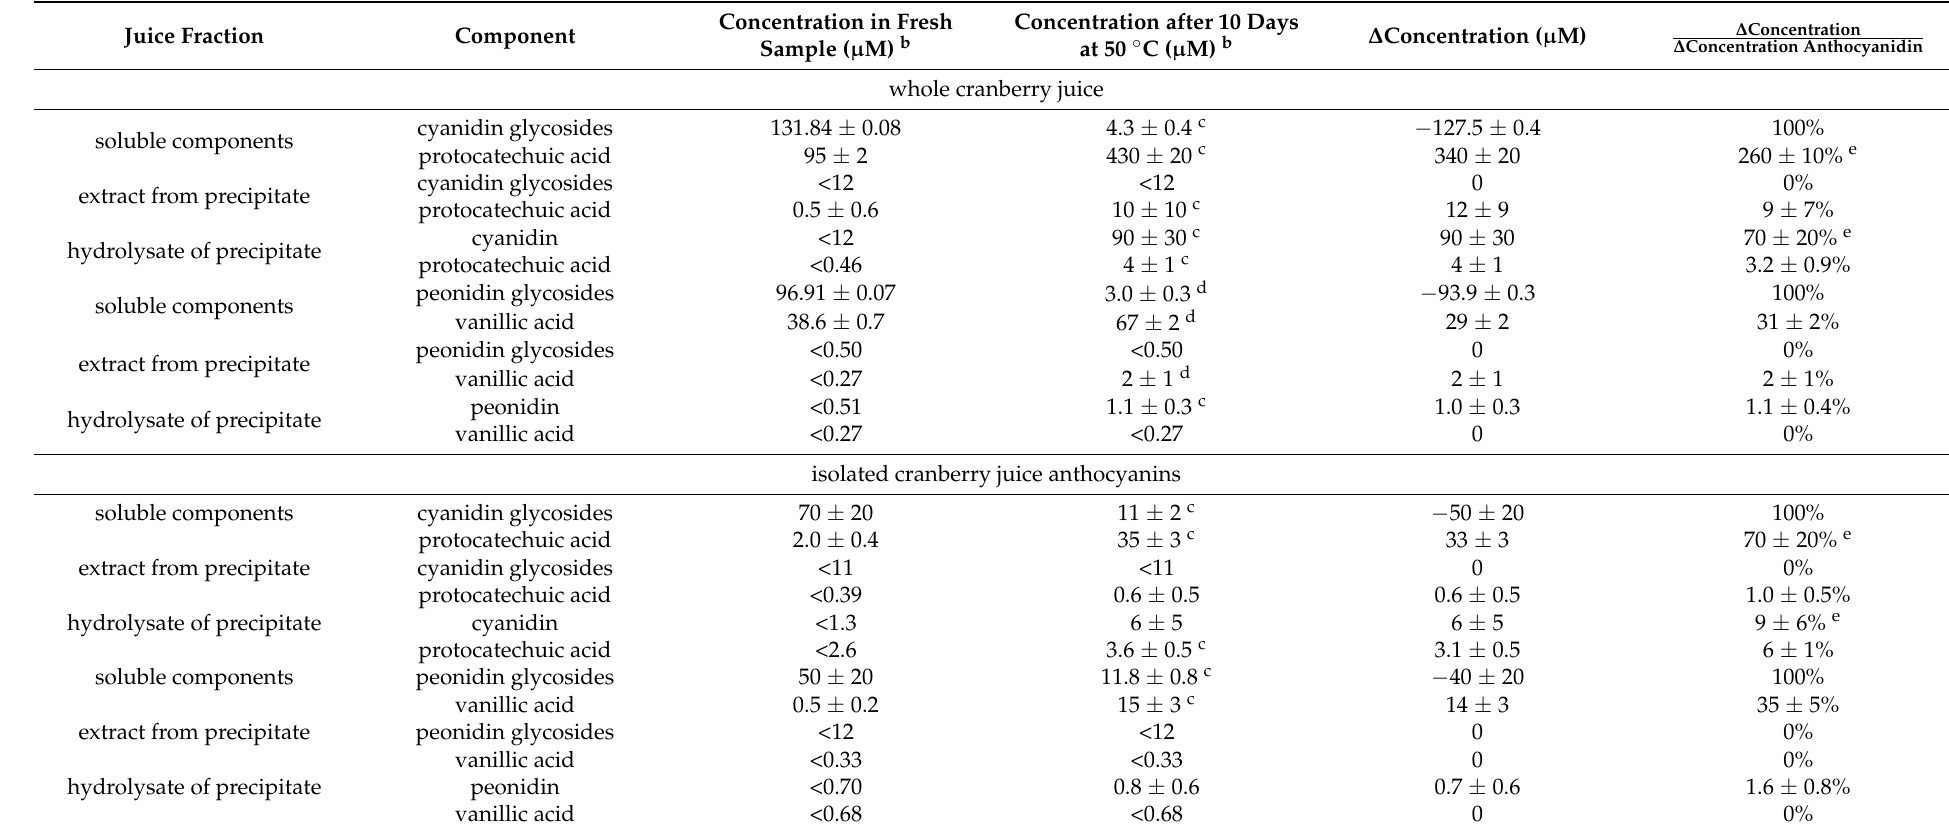
Table 2. Concentrations of anthocyanins, products of their loss processes, and normalized changes in the concentration of anthocyanin products as percentages with accelerated aging